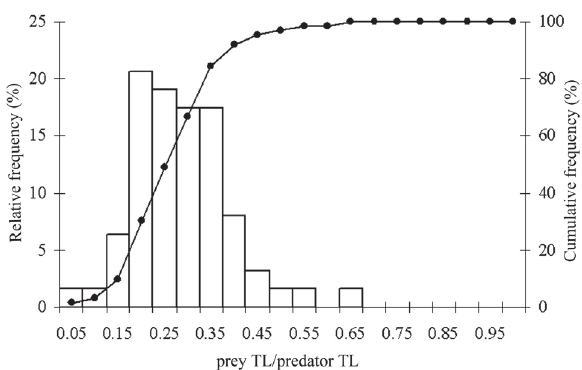
Fig . 8 – relative frequency distribution of prey size/predator size ratios consumed by S. saurus. cumulative frequency is indicated by a continuous line with filled circles at 5% intervals of prey size/ predator size